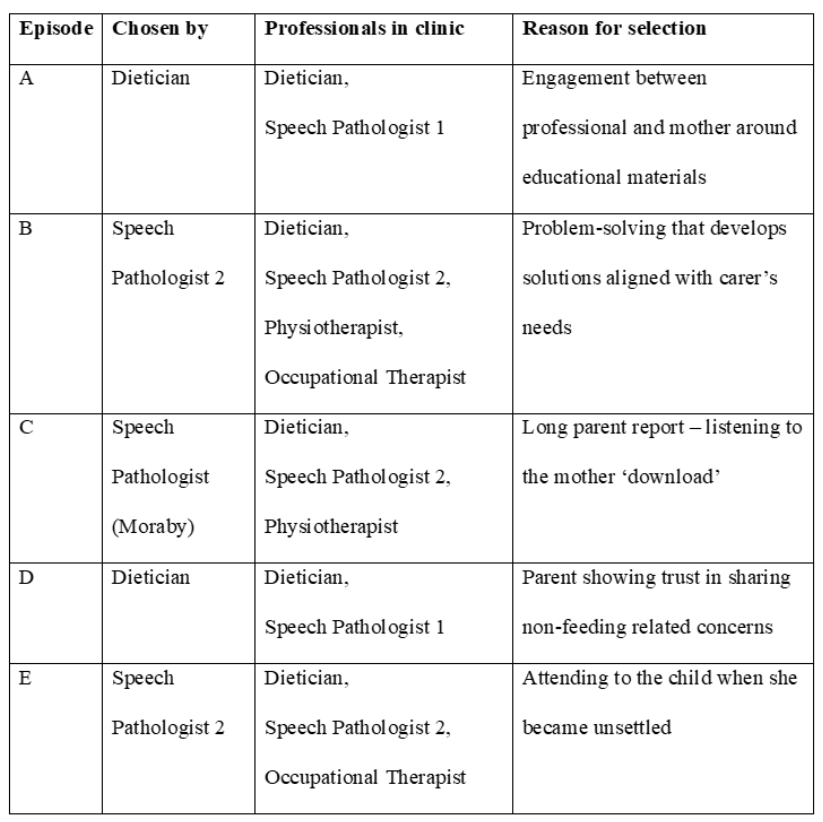
Table 1: Practice episodes identified by professionals as brilliant